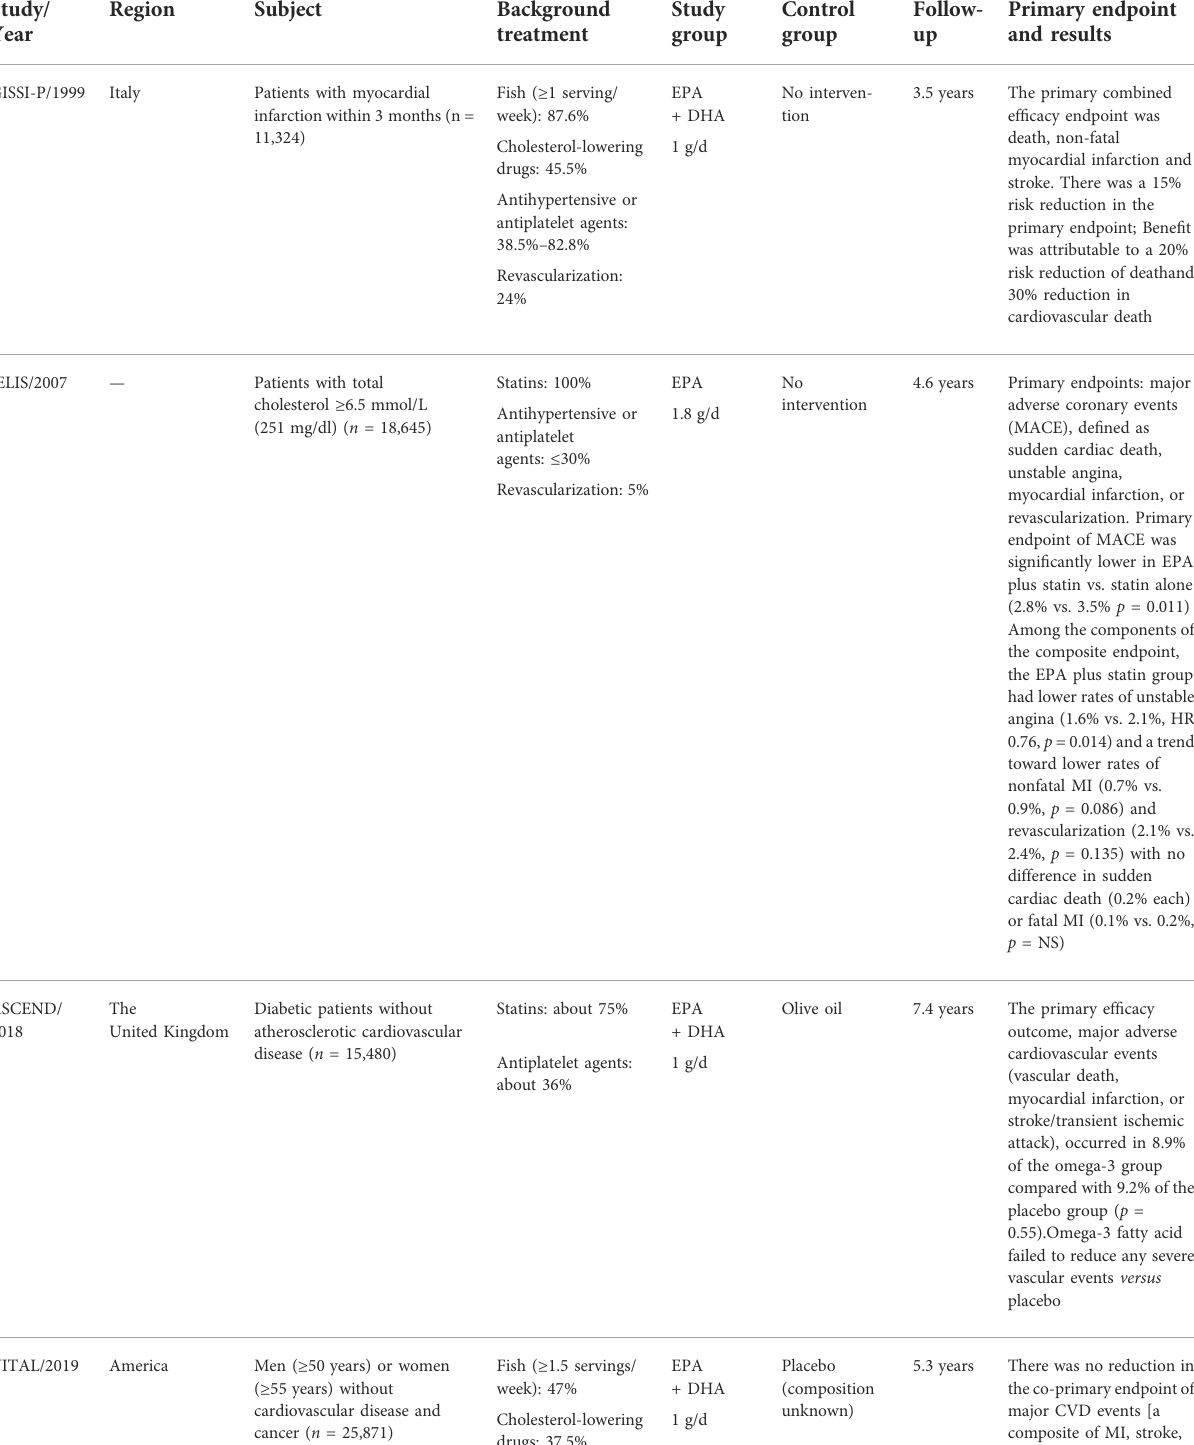
TABLE 2 Omega-3 fatty acids for prevention and treatment of atherosclerotic cardiovascular diseases. Study/